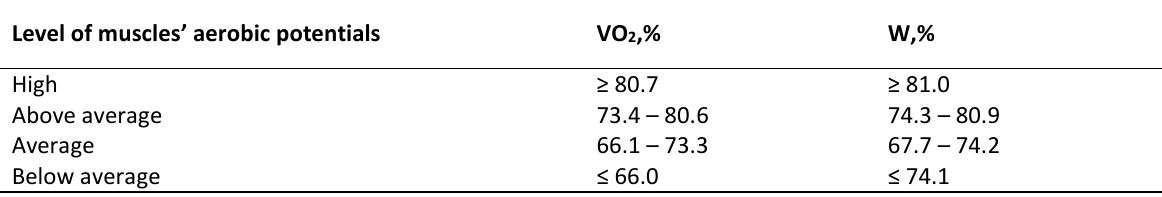
Table2. Integral assessment of muscles’ aerobic potentials of elite sportsmen, considering power and oxygen consumption at EMGT 2